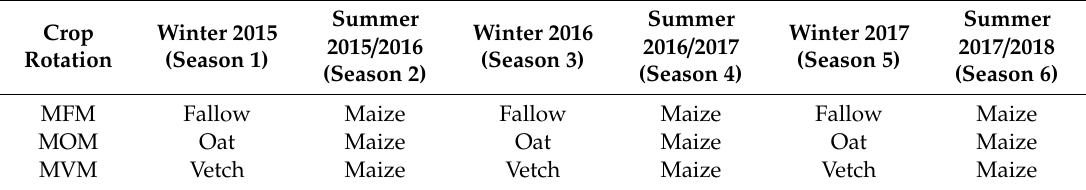
Table 1. Summary of crops grown for the duration of the trial investigating the interaction of tillage, crop rotation, and crop residue management from 2015 to